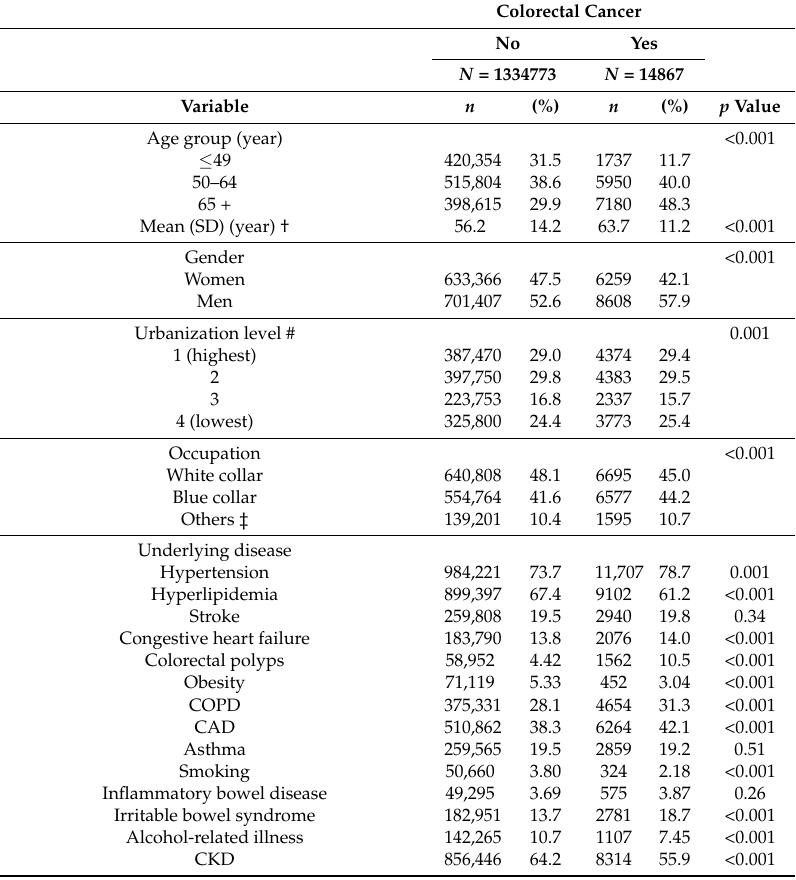
Table 2. Baseline characteristics of T2DM patients with and without colorectal